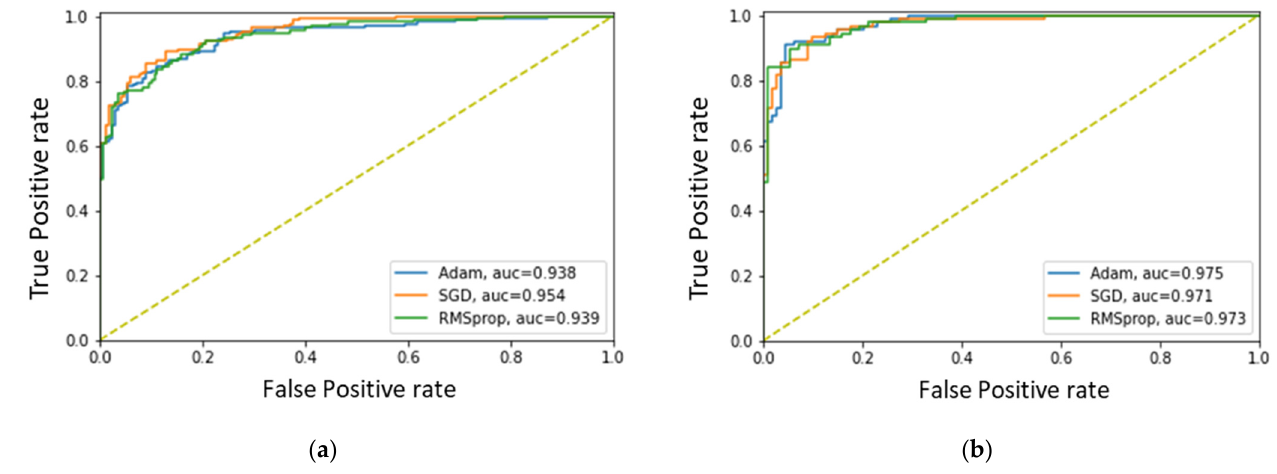
Figure 11. ROC curves of the proposed method using the ( a ) 3 s and ( b ) 5 s signal segments. Table 8. Comparison of the best performing method with and without data augmentation.